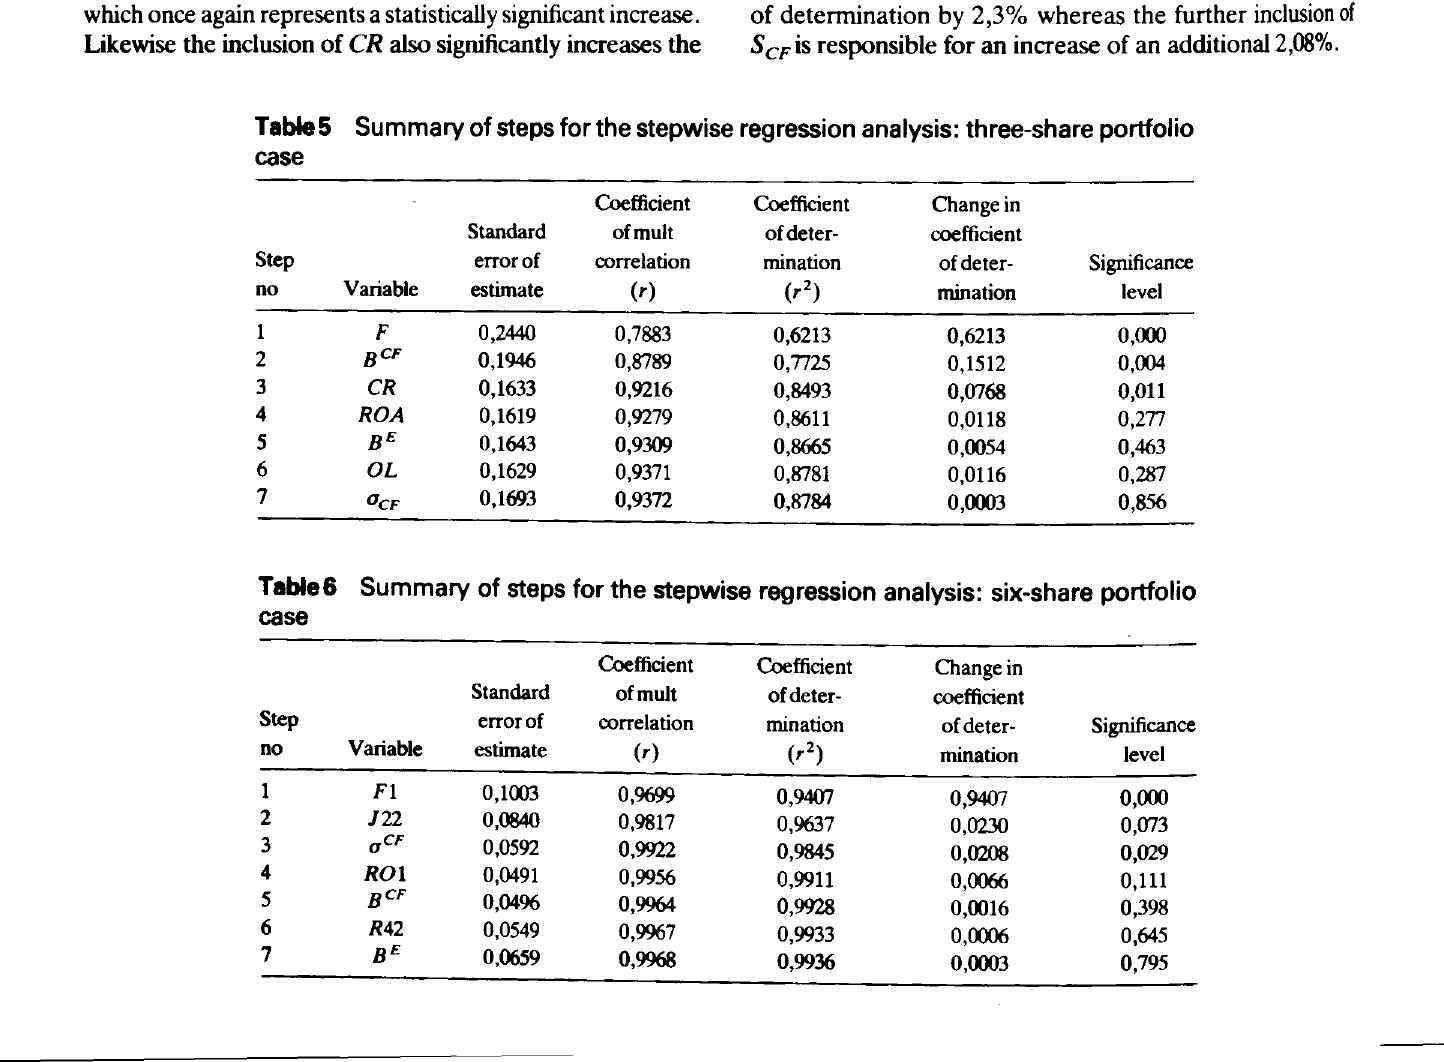
Table5 Summary of steps for the stepwise regression analysis: three-share portfolio